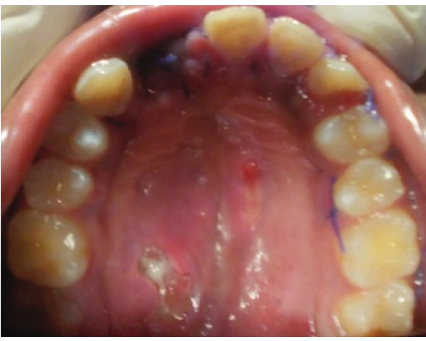
Figure 4: 1 week postoperative photograph showing palatal